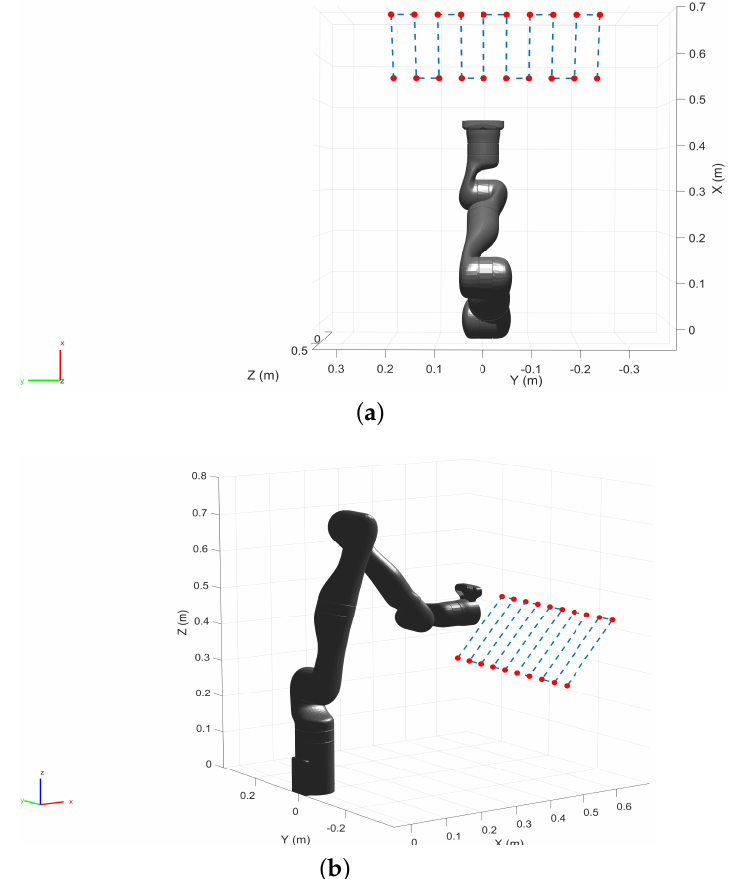
Figure 5. Spatial data points are generated to collect test dataset. While the robot moves to each of the locations with a raster motion, the position and the orientation of the end-effector along with the joint angle are logged. ( a ) Top view. ( b ) Perspective view.